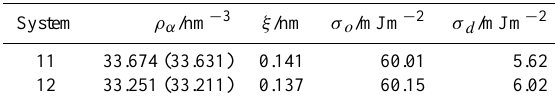
Table 4. Calculated liquid density, fitting parameter ξ , original part and dispersion correction of surface tension for planar interfaces in systems 11–12. Shown in parentheses are the densities obtained by fitting to the error function.